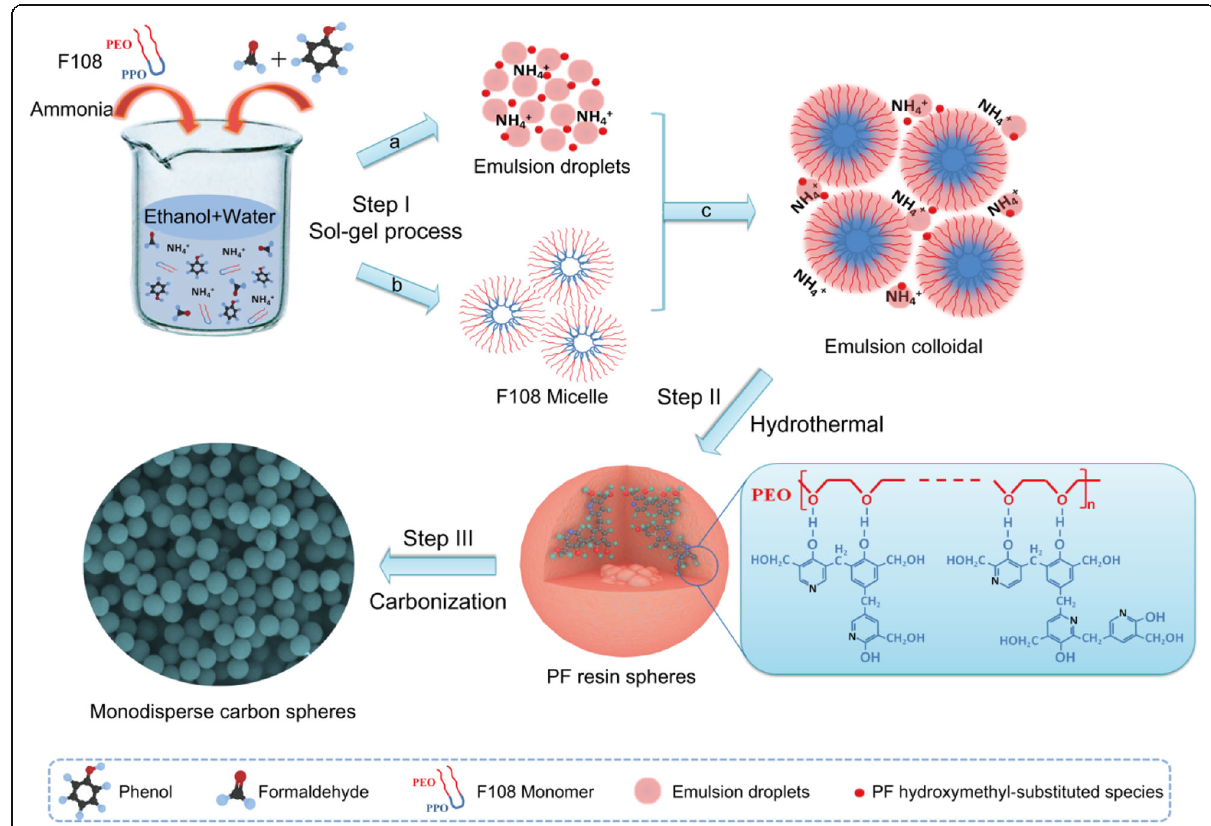
system. Additional file 1: Figure S1a presents the SEM image of the carbon spheres obtained in the absence of F108. The products have a non-uniform particle size and encounter agglomeration. Furthermore, the particle size decreases systematically with increasing F108 dosage from 20 to 80 mg, and small particles and flaky sub- stances appear on the surface of carbon spheres and fi- nally encounter great conglutination (Additional file 1: Figure S1b~d). The reason is that when the triblock co- polymer F108 is sufficient in the system, the surface ten- sion decreases, stronger cross-linking interaction occurs, and smaller-sized emulsion droplets and carbon spheres are formed. However, appropriate F108 concentration can balance the surface tension and cross-linking inter- action forces and obtain the smooth surface and uni- formly sized carbon spheres. In addition, the effect of F108 concentration on the electrode properties of the MCSs was also investigated, as shown in Additional file 1: Figure S2. The result reveals that the triblock copoly- mer F108 played as a surface active agent for the forma- tion of MCSs. These synthesized MCSs may have some potential ap- plications such as catalysis, adsorption, and electrode materials for supercapacitors and lithium-ion